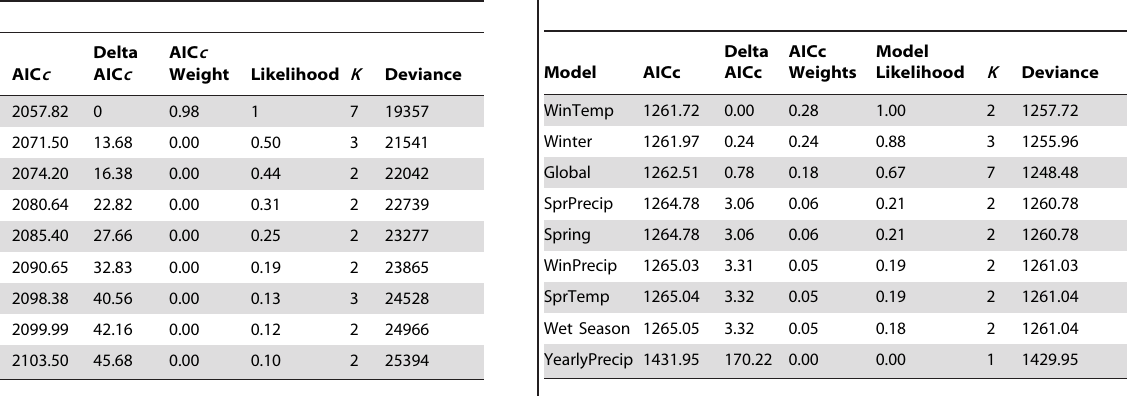
Table 4. Output from 9 a priori models used to assess the relationship between mean incubation initiation (Julian Date) and seasonal weather patterns for 207 nests in Roosevelt County, NM, and Cochran, Hockley, Terry, and Yoakum